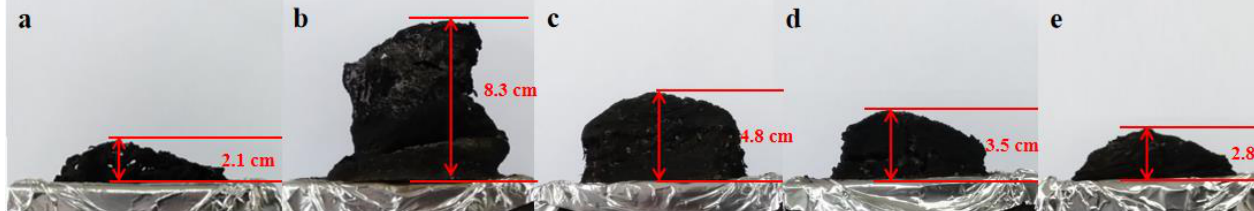
Figure 10. Digital photos of char layers of EP/DDS ( a ), EP/DDS/HPCP − 9 ( b ), EP/DDS/HPCP − 8/H − U − 1 ( c ), EP/DDS/HPCP − 7/H − U − 2 ( d ), and EP/DDS/HPCP − 6/H − U − 3 ( e ) after cone tests.